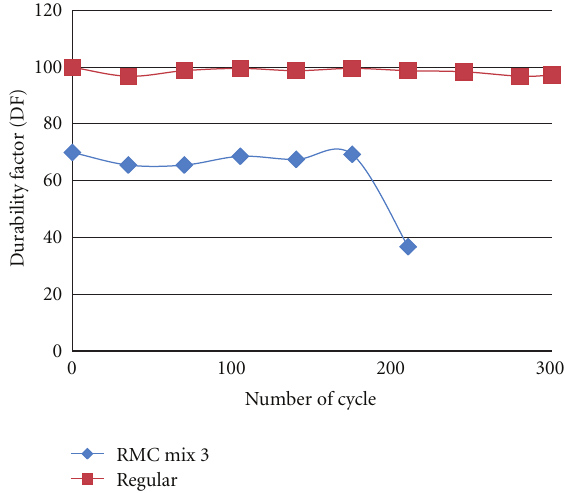
Figure 11: Average durability factor versus no freeze-thaw cycles.